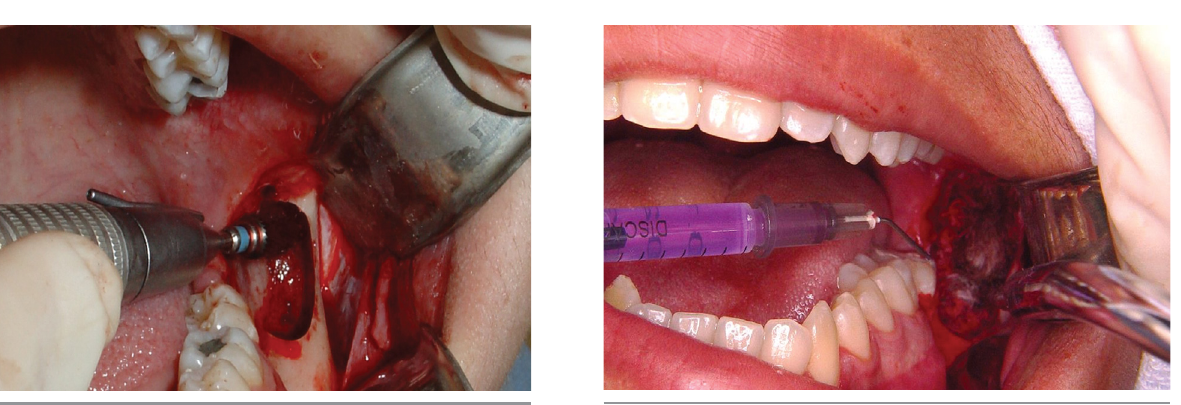
Figure 3. Peripheral ostectomy. Figure 4. The application of Carnoy’s